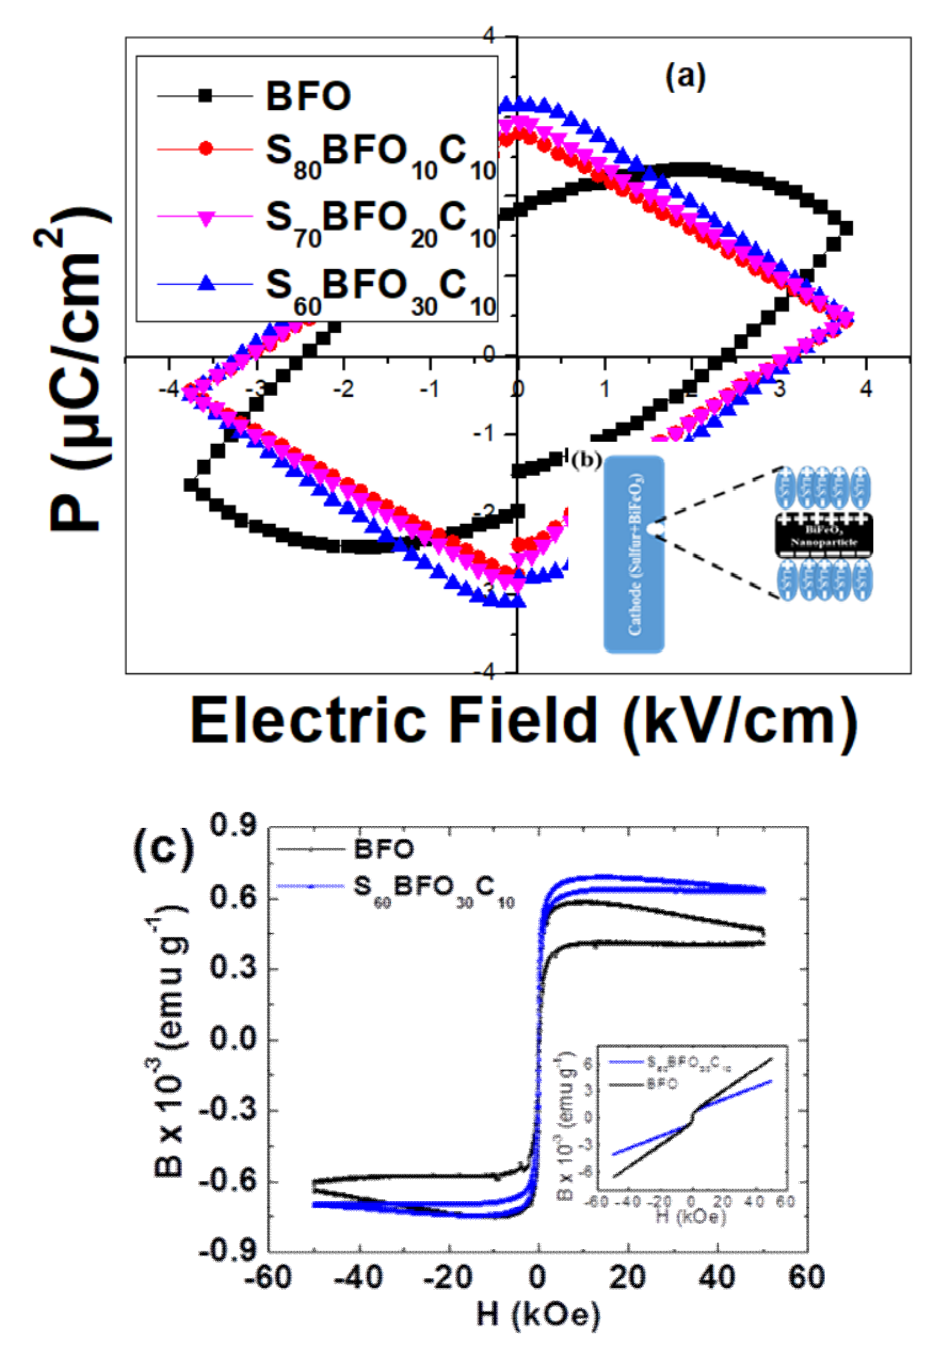
Figure 4. ( a ) Room temperature ferroelectric (P–E) hysteresis loop for BFO–C-Sulfur composite cathode materials together with pristine BFO ferroelectric hysteresis loop, and ( b ) schematic view of trapping heteropolar Li x S y clusters with ferroelectric BFO due to the charge separation in BiFeO 3 ferroelectric domains, and ( c ) room temperature magnetic hysteresis, with inset showing the raw data with large paramagnetic contribution in the higher